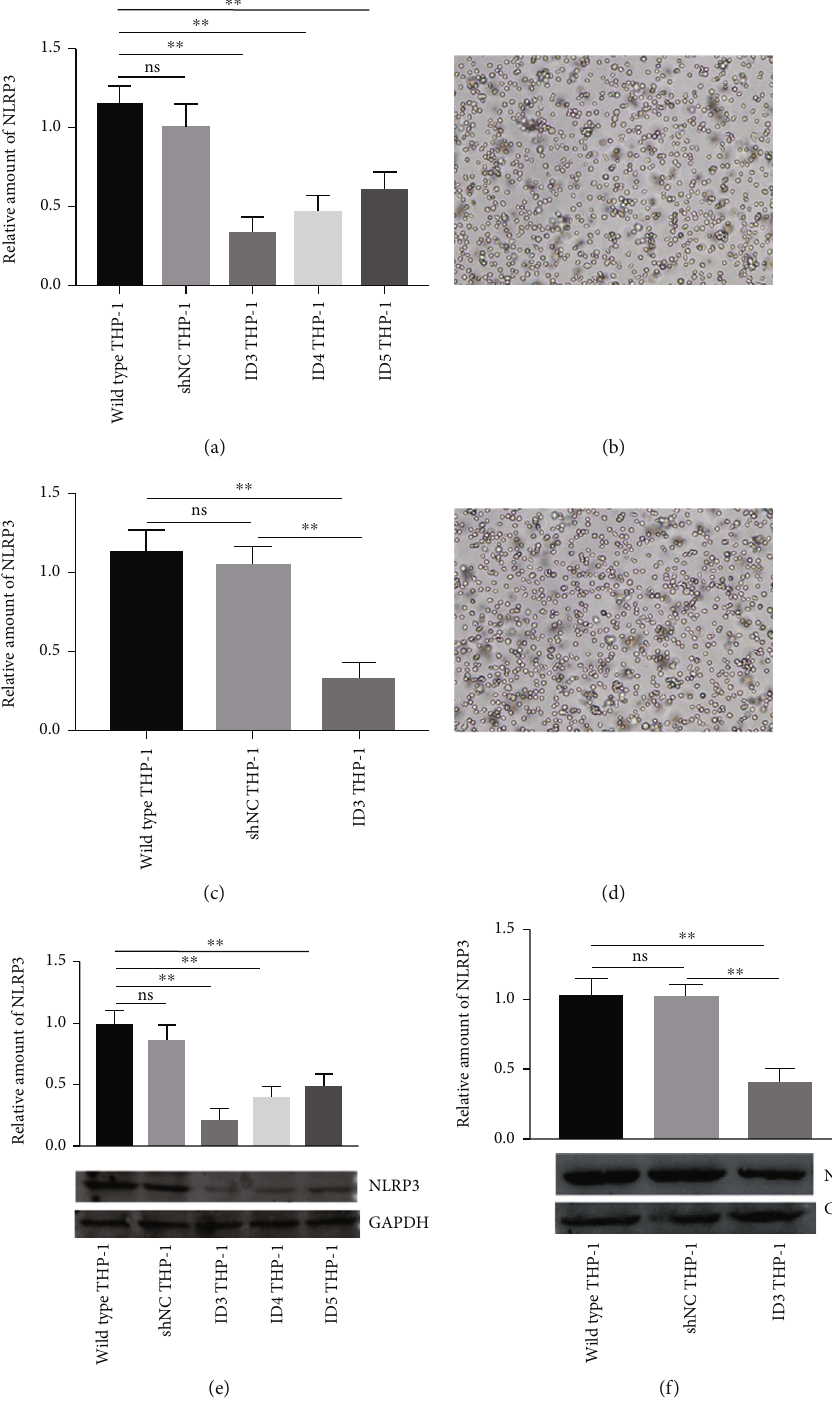
Figure 1: Results of CRISPR/Cas9 editing for NLRP3 in THP-1 cells and the stable transfectant THP-1 cell line. (a) Use of three programs to edit exons 9 (ID3), 7 (ID4), and 5 (ID5) of the NLRP3 gene in THP-1 cells. The shNC indicated nontargeting control. The expression of NLRP3 was determined via QRT-PCR. All three schemes can signi fi cantly downregulate the NLRP3 gene expression, and ID3 obtained the optimal regulation results. ID3 THP-1 was used in the follow-up study. (b) – (d) Microscopic examination results (100 × ) of THP-1 cells stably transfected with shNC and ID3 vector. Cells demonstrated normal morphology and ability to proliferate and generate. (c) NLRP3 expression in the stable transfectant ID3 THP-1 cell line tested via QRT-PCR. The expression of NLRP3 in ID3 THP-1 was still stable and low after more than three passages. (e) Evaluation of the regulatory e ff ect of three gene-editing schemes on NLRP3 via immunoblot. ID3 showed optimal ability to downregulate the NLRP3 expression. (f) NLRP3 expression in the stable transfectant ID3 THP-1 cell line tested using immunoblot. The result was similar to that obtained via QRT-PCR. ∗∗ p < 0 : 01 , ns: not signi fi